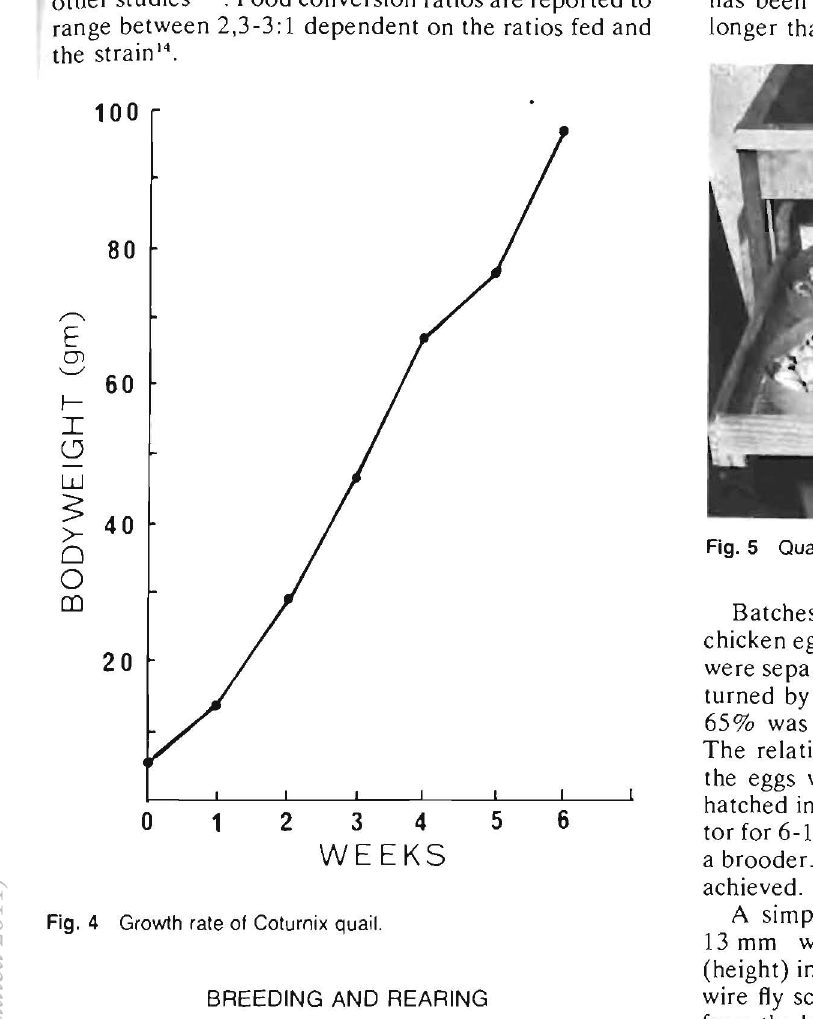
BREEDING AND REARING